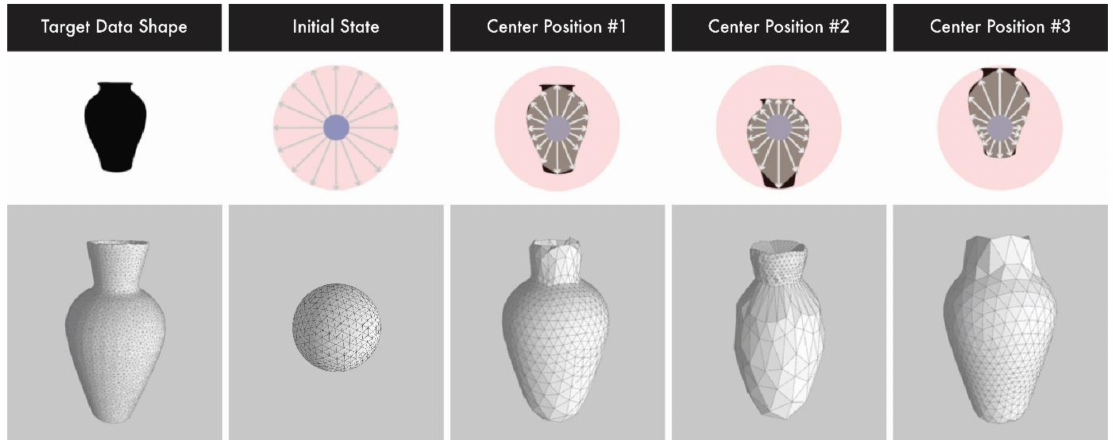
Figure 9. Example of resultant differences according to the center position. Depending on the surface at which the visual significance feature is located, the center position is changed by assigning an additional weight to the